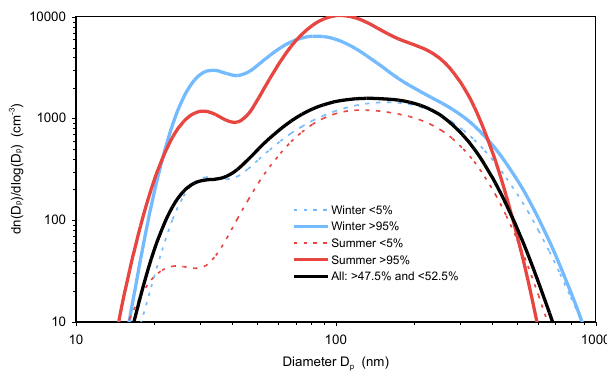
Fig. 6. Median number size distributions at 300m height in air masses with the smallest ( < 5%, dashed), and highest ( > 95%, full lines) values of the total number concentration at ZOTTO in sum- mer (May through August, red), and winter (November through February, blue). In black: Median number size distributions in all air masses with values between 47.5 and 52.5% of the total number concentration.